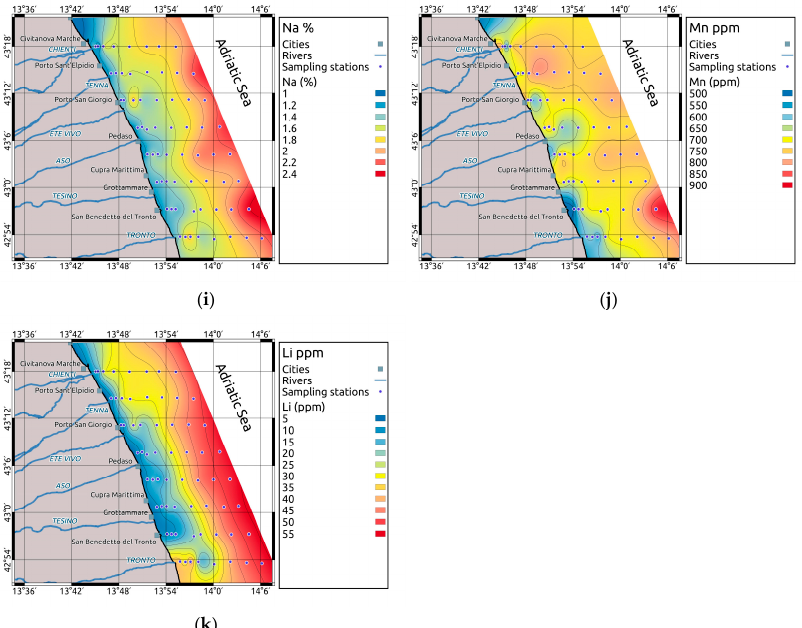
Figure 6. Areal distribution of the elements in surface sediments. ( a ) Al, ( b ) Fe, ( c ) K, ( d ) Mg, ( e ) S, ( f ) Ca, ( g ) Ti, ( h ) P, ( i ) Na, ( j ) Mn, and ( k ) Li.